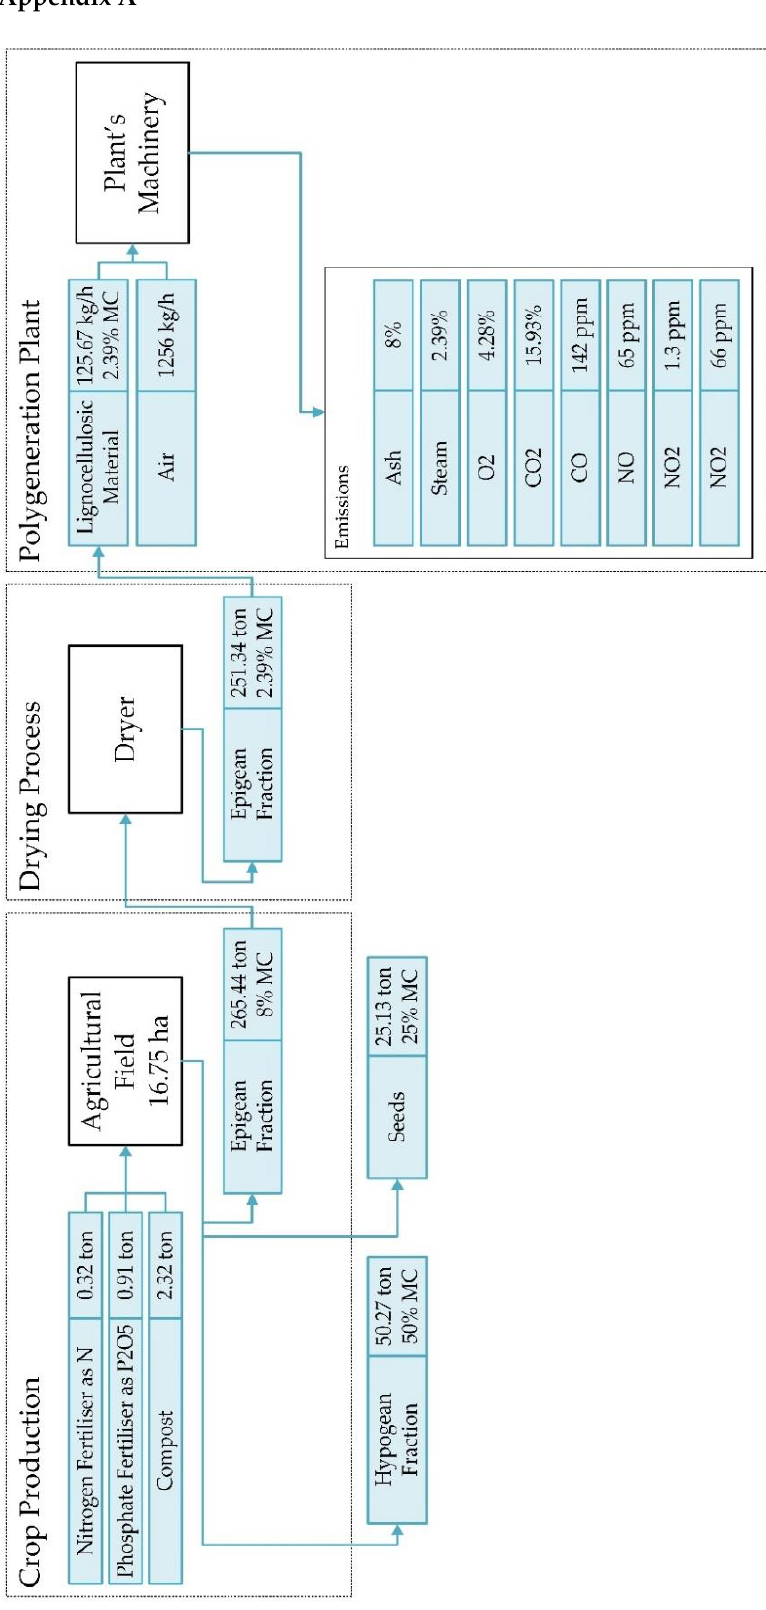
Figure A1. Annual mass flows from crop production to the polygeneration phase, and emission rate. MC — moisture content.